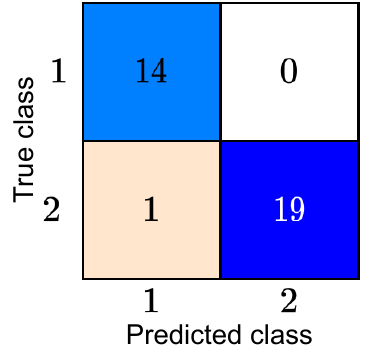
Figure 10. Confusion matrix for Classes 1 and 2.